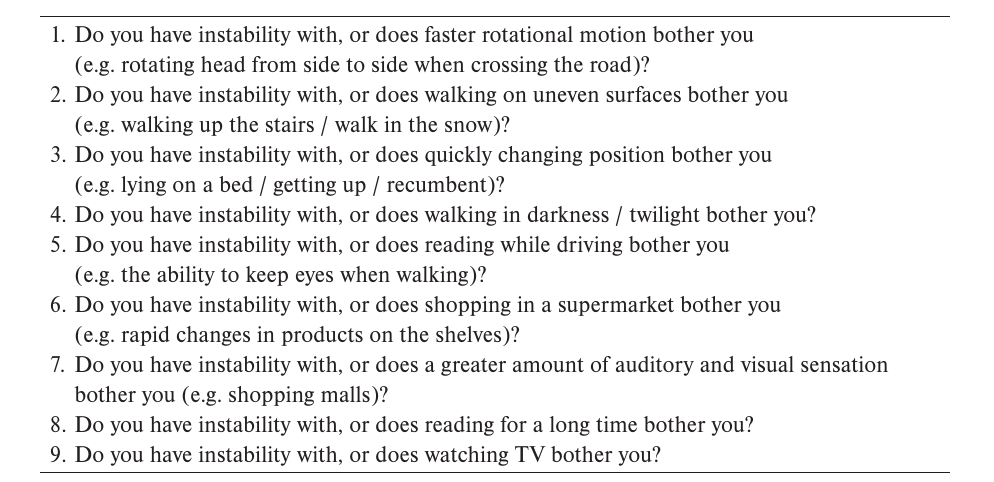
Table 2. Additional questions